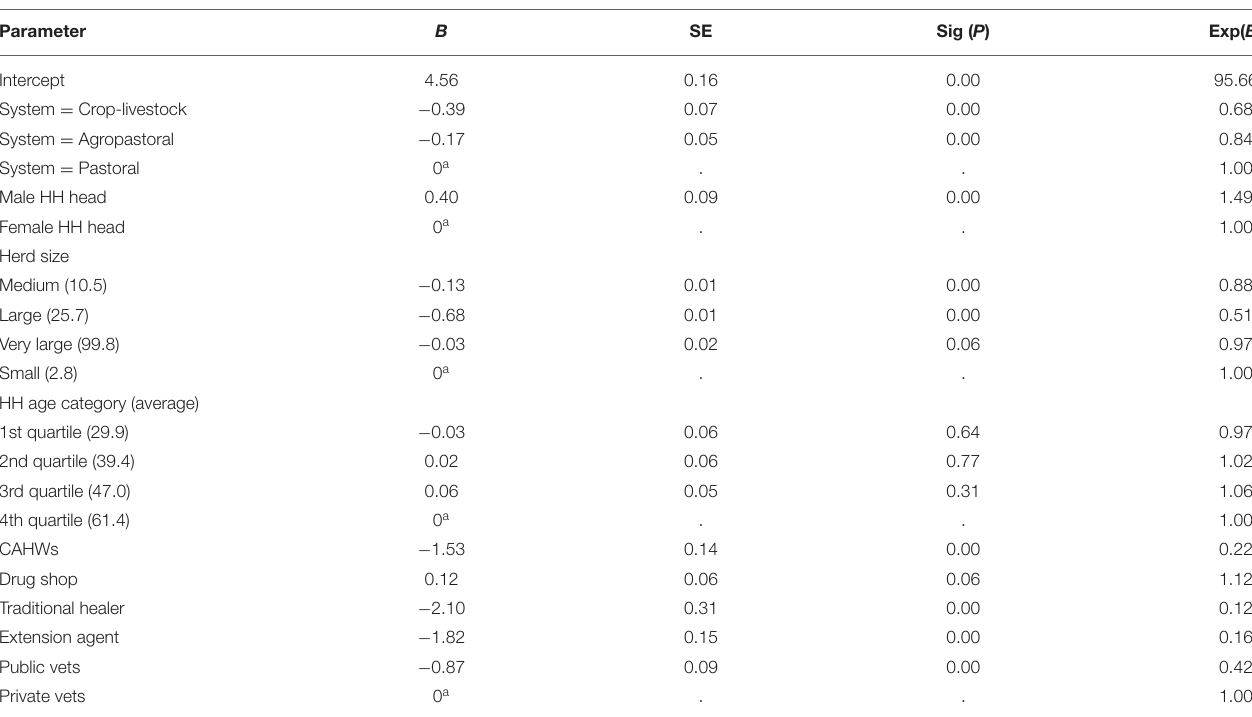
TABLE 8 | The odds of [Exp(B)] a livestock keeper from the different livestock systems, gender and age categories and using the different service providers expending a higher amount of money in reference to those in the reference category within each parameter. Parameter B SE Sig ( P ) Exp( B ) Intercept